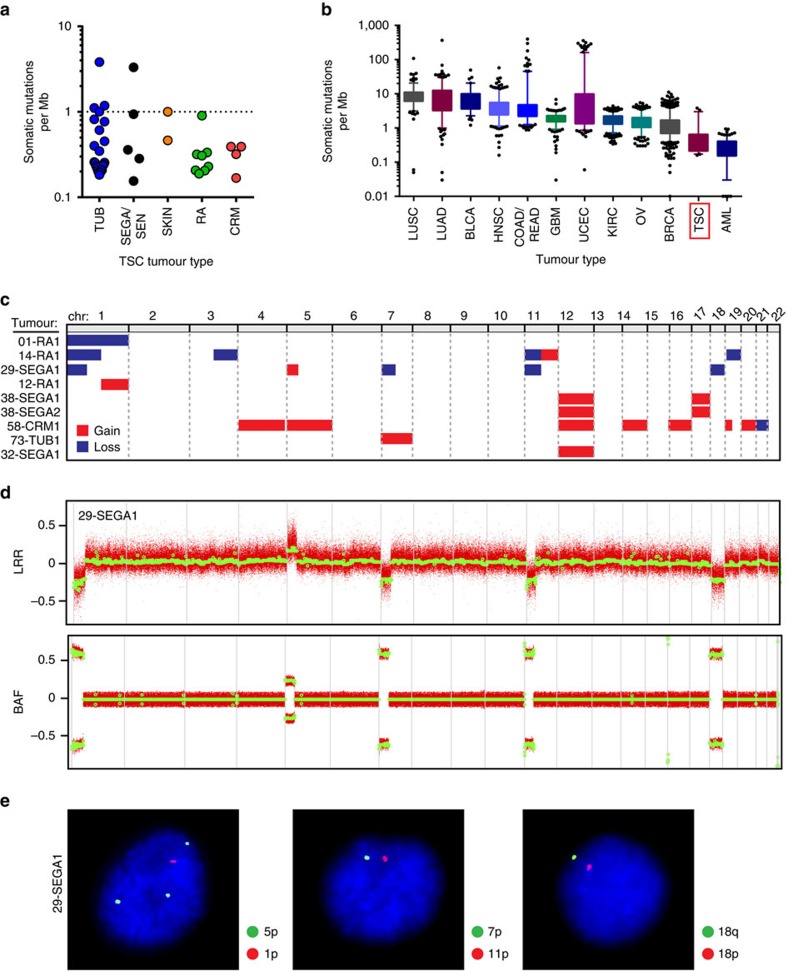
TSC lesions are infrequently mutated with large chromosome aberrations identified in a subset.(a) Each symbol represents the number of somatic mutations, including point and INDELs, per Mb of genomic DNA. (b) Somatic mutations per Mb for cancerous and TSC lesions shown as boxes (25th to 75th percentile) and whiskers (5th to 95th percentile). Outliers shown as individual data points. (c) GISTIC was used to call whole and arm-level CNAs using processed SNP array data. Gains (3n) are shown in red and losses (1n) are shown in blue. (d) All CNAs were visually confirmed with genome-wide LRR and BAF plots. 29-SEGA1 is shown as an example. (e) FISH was used to confirm large CNAs. Representative nuclei, stained with DAPI in blue, show single fluorescent puncta using probes to chromosome 1p, 11p, 7p, 18p and 18q, and three fluorescent puncta using a probe to chromosome 5p, confirming losses and gains, respectively. AML, acute myeloid leukemia; BLCA, bladder urothelial carcinoma; BRCA, breast invasive carcinoma; COAD, colon adenocarcinoma; GBM, glioblastoma multiforme; HNSC, head and neck squamous cell carcinoma; KIRC, kidney renal clear cell carcinoma; LUAD, lung adenocarcinoma; LUSC, lung squamous cell carcinoma; OV, ovarian serous cystadenocarcinoma; READ, rectum adenocarcinoma; TSC, tuberous sclerosis complex; UCEC, uterine corpus endometrial carcinoma.